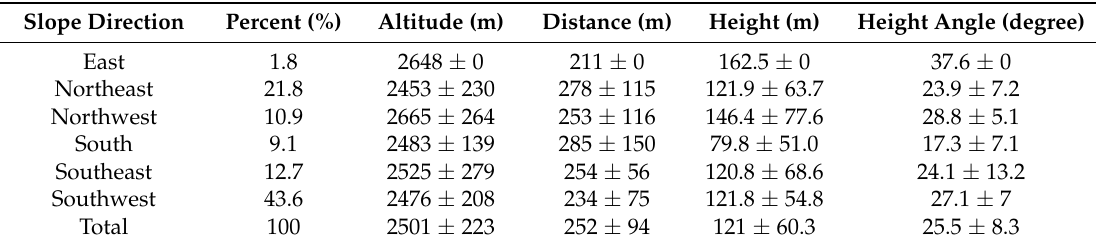
Table 1. Essential information of sample plots.